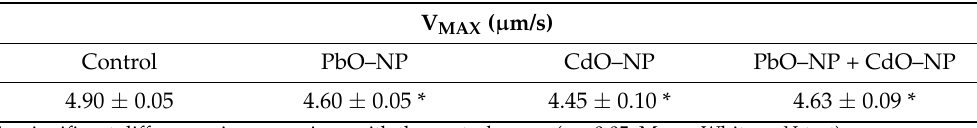
Table 3. The velocities of regulated thin filament sliding movement over rat ventricular myosin in all experimental groups ( X(cid:3365) ± s.e.)